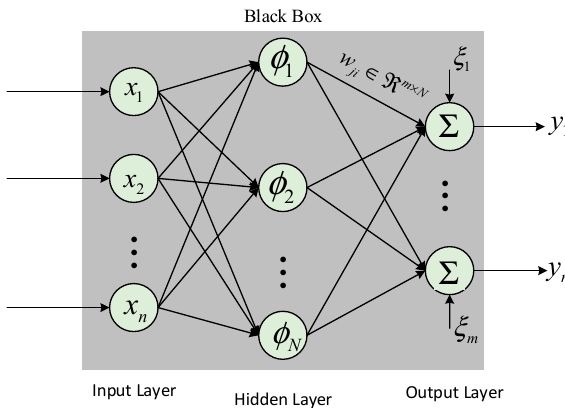
Figure 2. Structure of a multiple-input multiple-output radial basis function neural network (RBFNN).